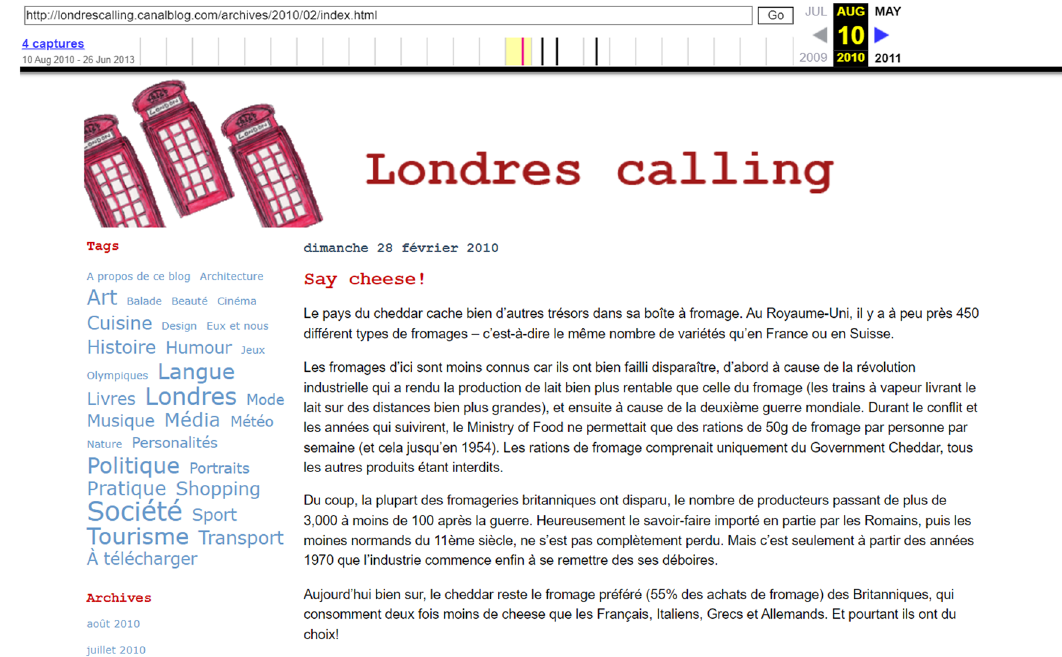
Fig. 2 Londres Calling landing page, archived 10 August 2010. The telephone-booth iconography of the banner again presents London stereotypically, but the language is semiotically more complex. This fi gure is not covered by the Creative Commons Attribution 4.0 International License. Reproduced with permission of Léa Teuscher; copyright ©londrescalling.blog, all rights